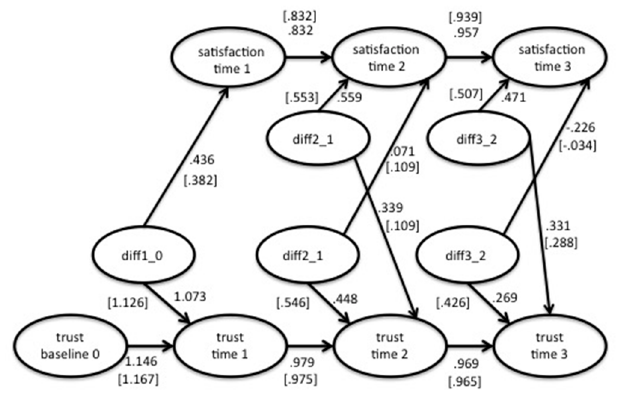
Figure 4 . Bivariate coupling model. Latent change in trust influencing satisfaction and latent change in satisfaction influencing trust. Standardized parameter estimates for affective trust are not bracketed; those for cognitive trust are given in brackets. All estimates are significant p < 0.01. For clarity, the measurement model and indicator specific latent variables are not presented.